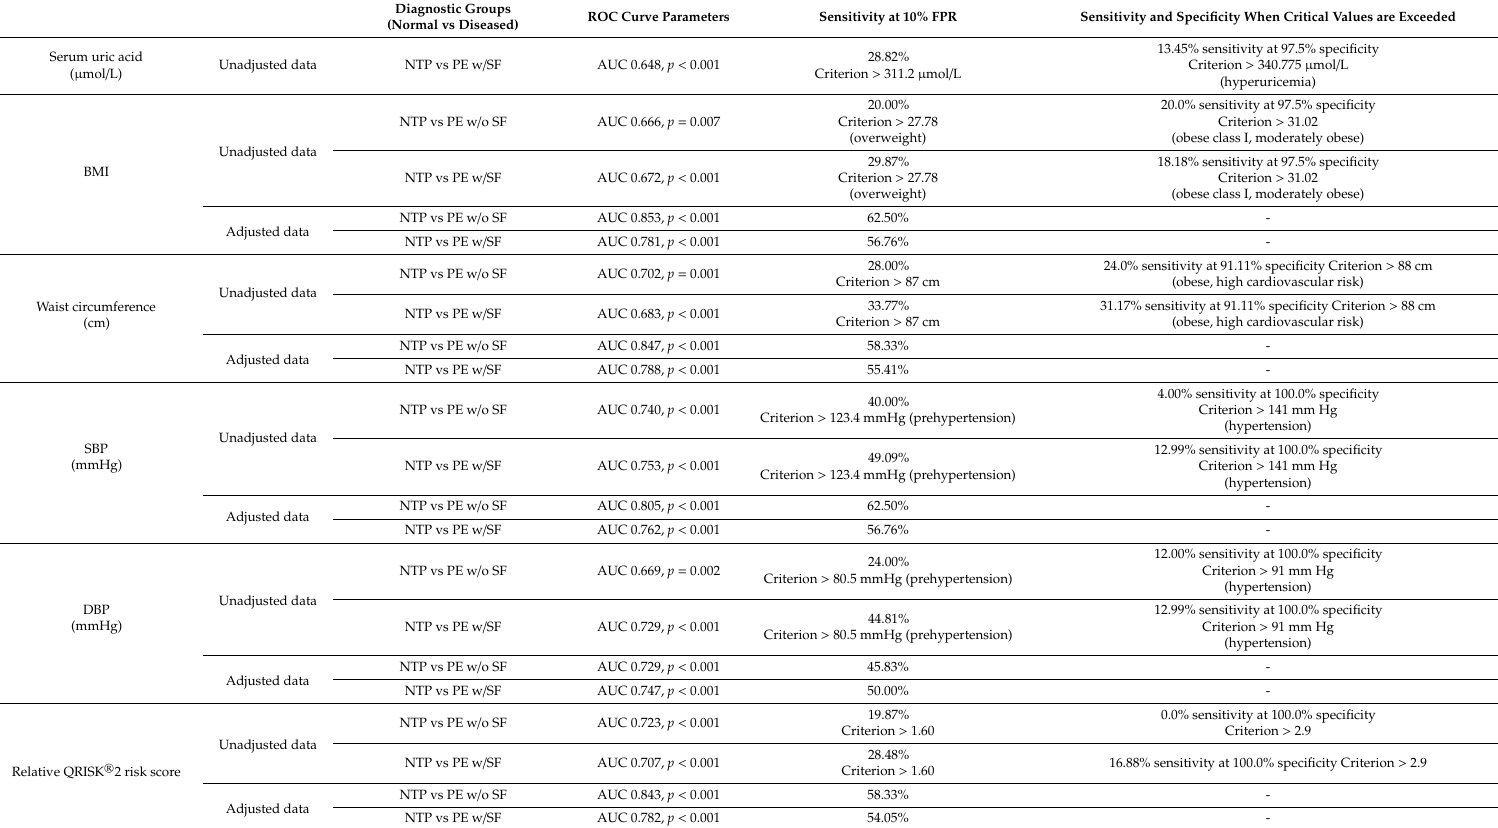
Table 5. Impact of severity of PE on maternal cardiovascular risk - overview (ROC curve